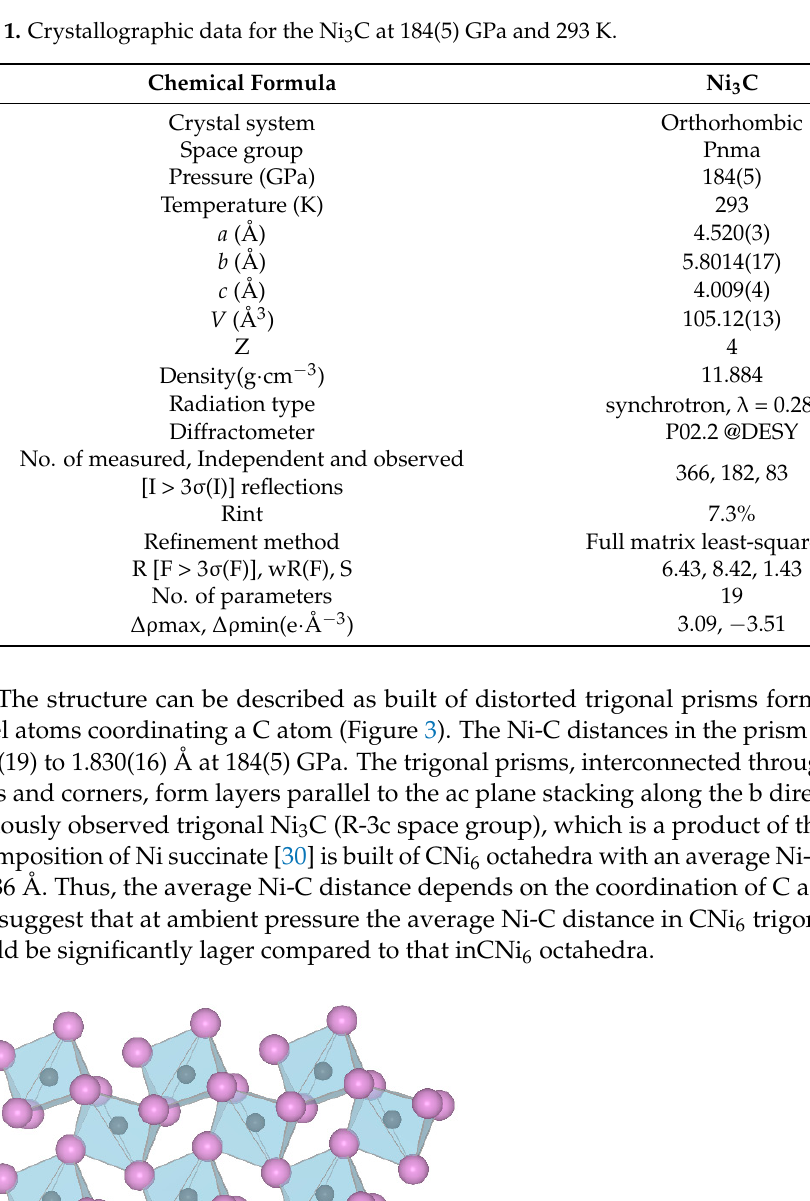
Table 1. Crystallographic data for the Ni 3 C at 184(5) GPa and 293 K.